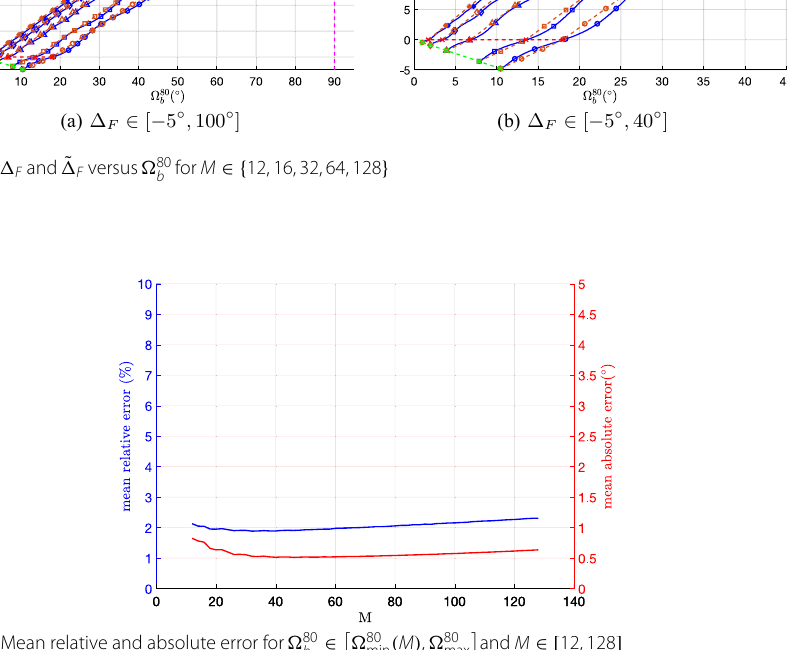
Fig. 10 (cid:31) F and